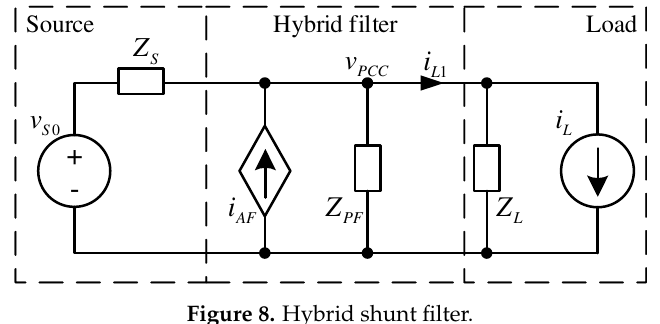
Figure 8. Hybrid shunt